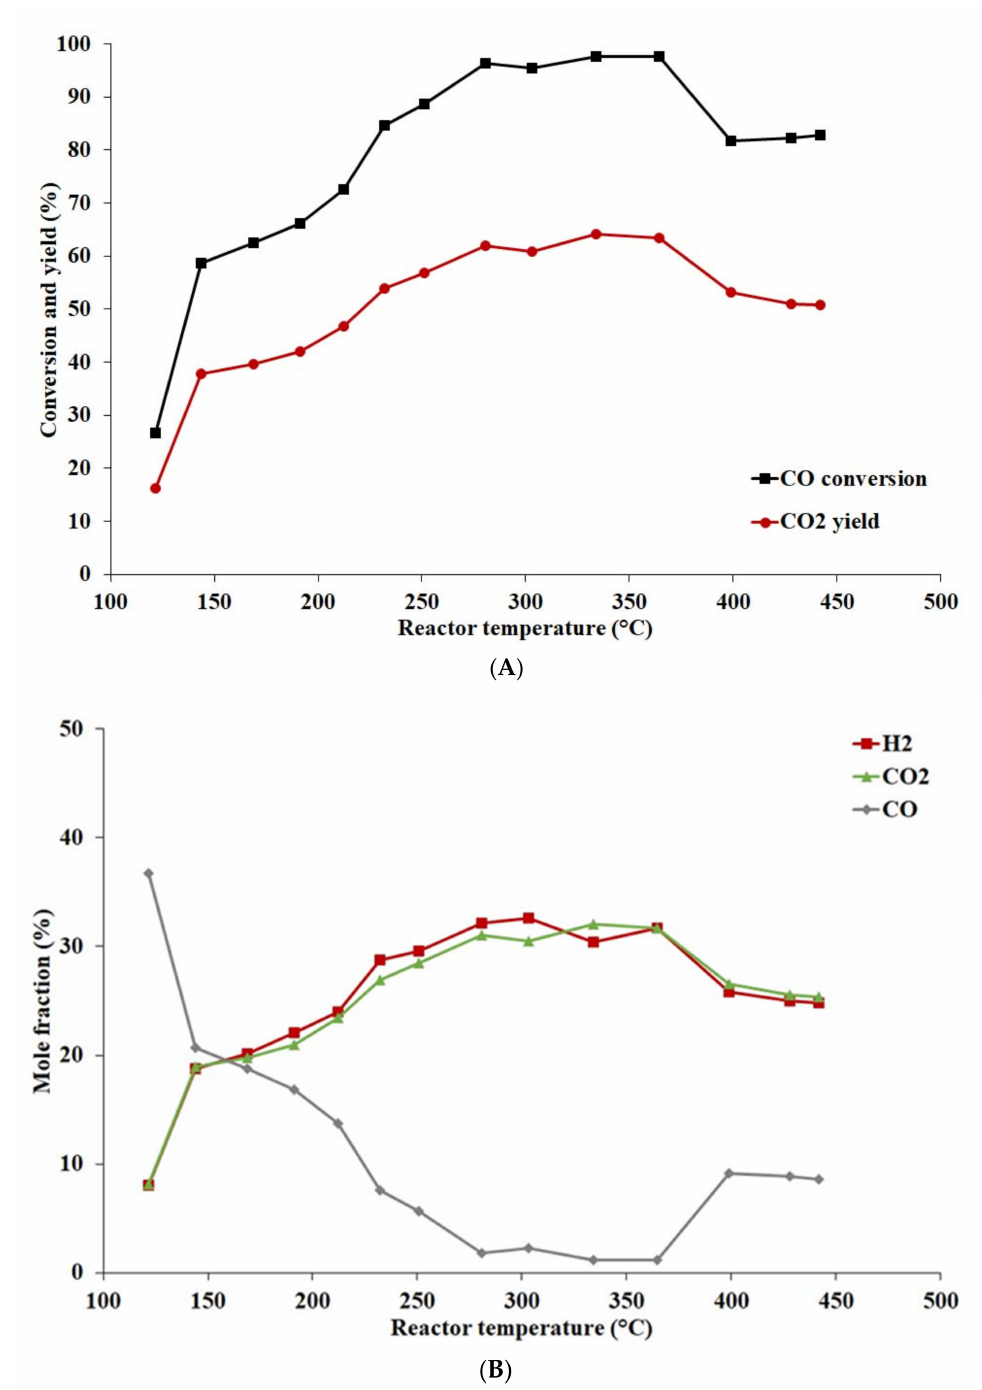
Figure 11. Catalytic tests on a Cu-based (14.8 wt%) activated catalyst prepared with calcined support with feed gas mixture 1 (50 mole% CO, 50 mole% N 2 ) at pressure 0.5 MPa: ( A )—CO conversion and CO 2 yield; ( B )—composition of produced